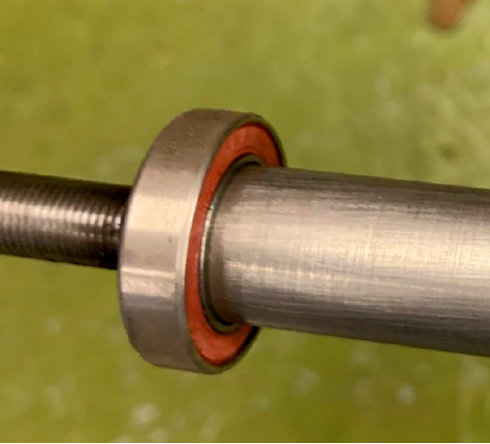
Figure 10. Bearing press fitted onto shaft.